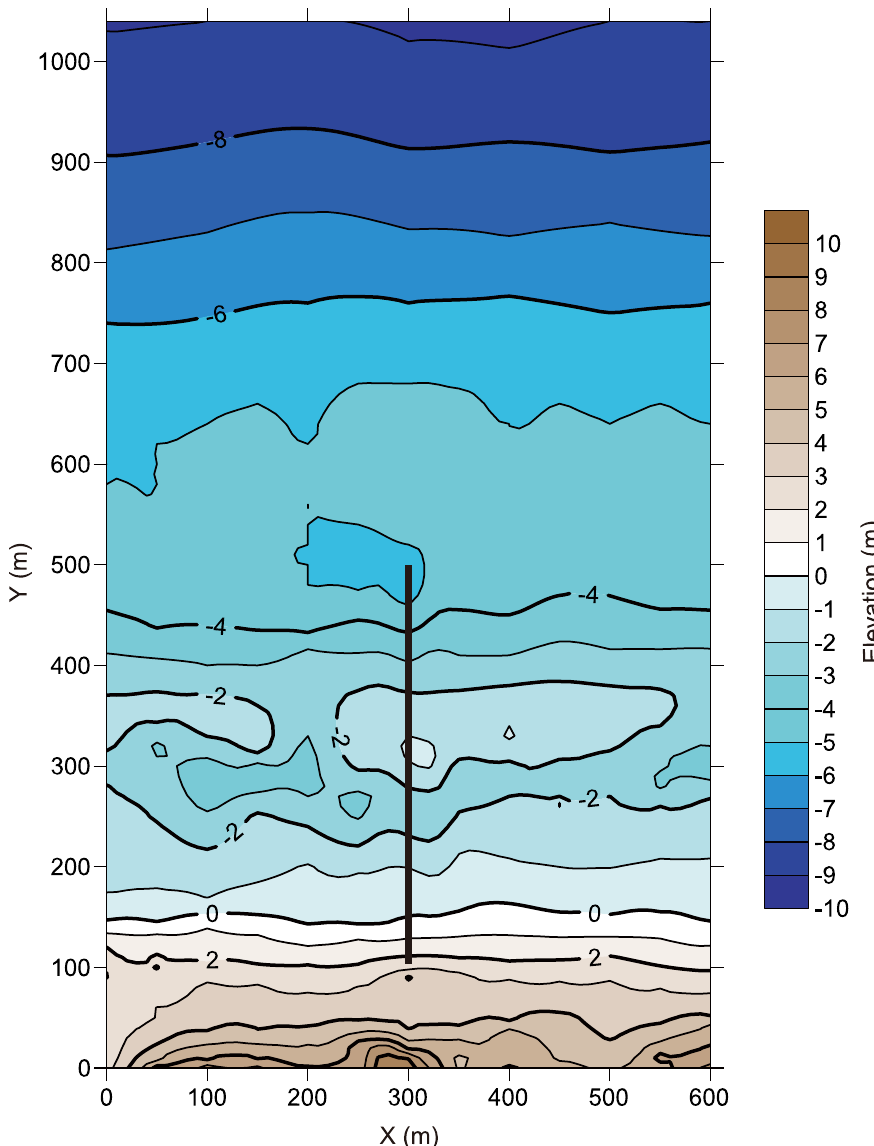
Figure 2. The bathymetry around the pier on February 15, 2020.